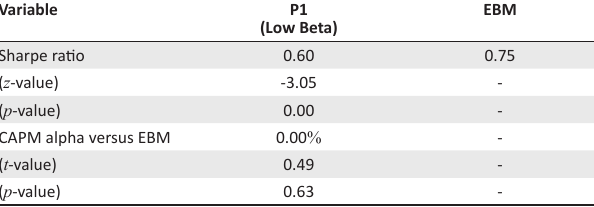
TABLE 6: Risk-adjusted performance of the low-beta quintile portfolio. Variable